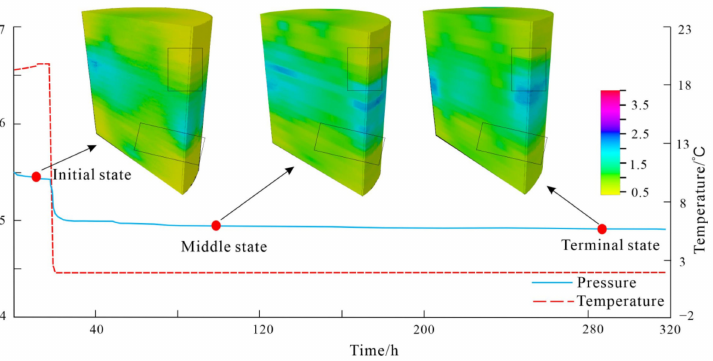
Figure 5. Three-dimensional resistivity image of the layered hydrate during the formation of hydrate. The top and bottom boundary of images are the same as those of massive